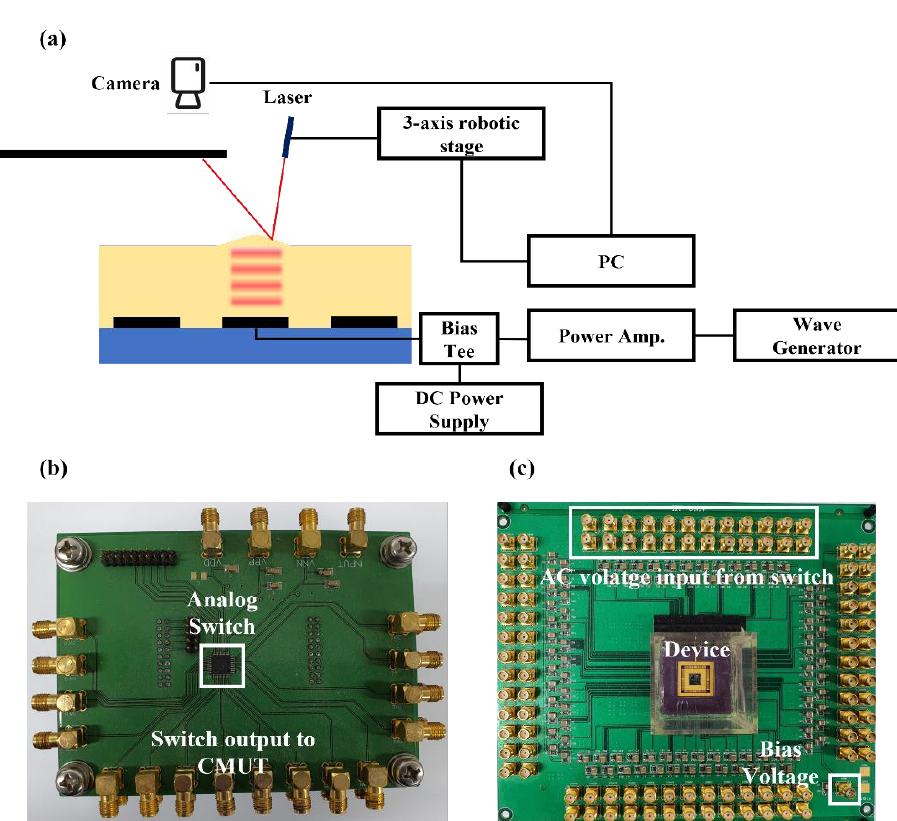
Figure 3. ( a ) Measurement system for the surface height of oil with a laser; ( b ) photograph of the channel-switching PCB board; ( c ) photograph of the CMUT-operating PCB board.